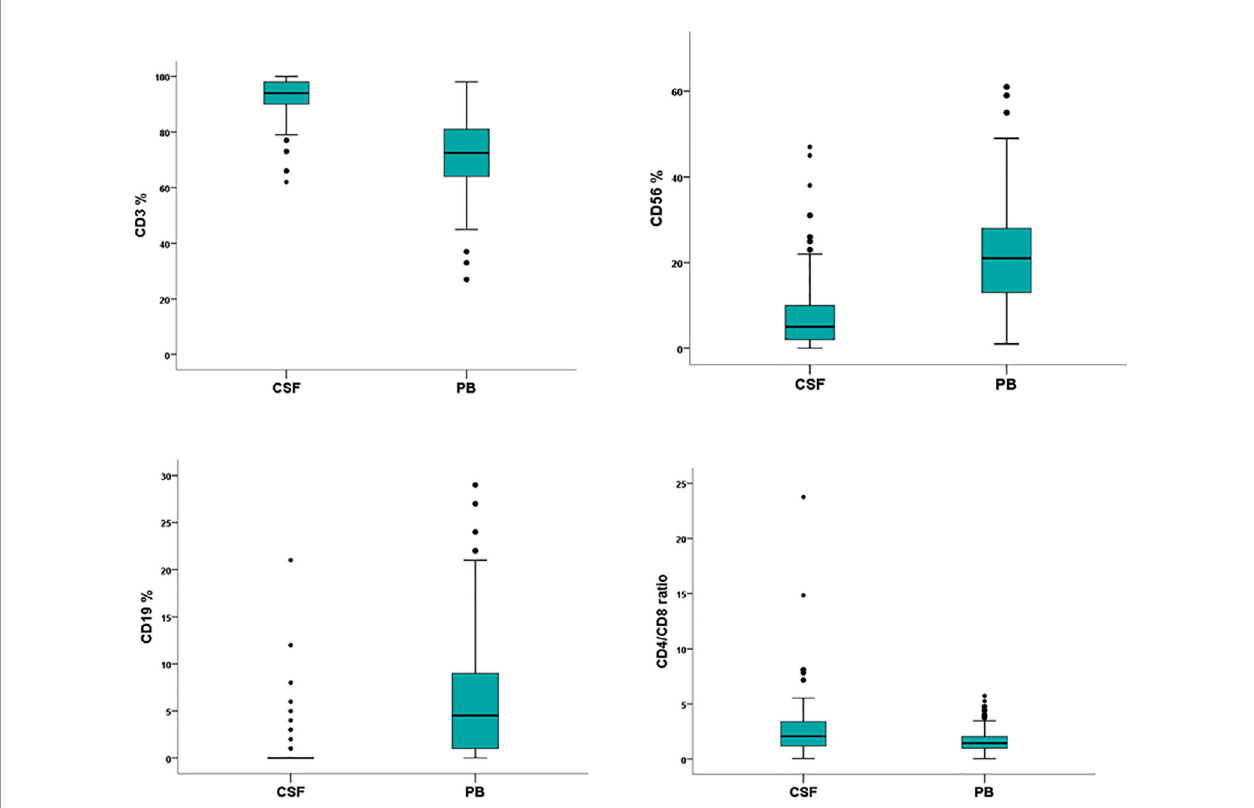
FIGURE 3 | Flow cytometry characterization of cerebrospinal fl uid (CSF) and peripheral blood (PB) lymphocytes in 107 non-Hodgkin lymphoma patients negative for leptomeningeal involvement. Wilcoxon rank-sum test documents a signi fi cant different distribution between CSF and PB lymphoid